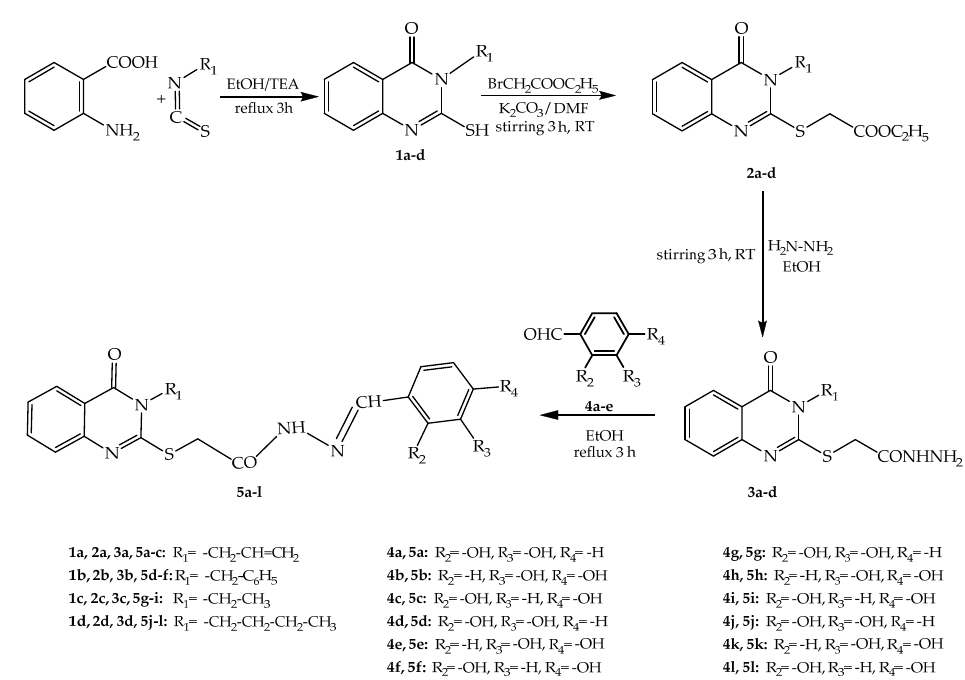
Figure 2. The synthesis steps followed in order to obtain compounds 5a – l